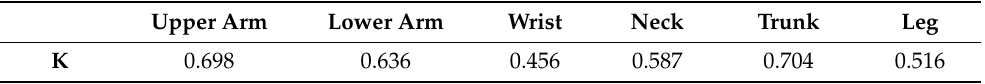
Table 4. Comparison between the results of the system and expert